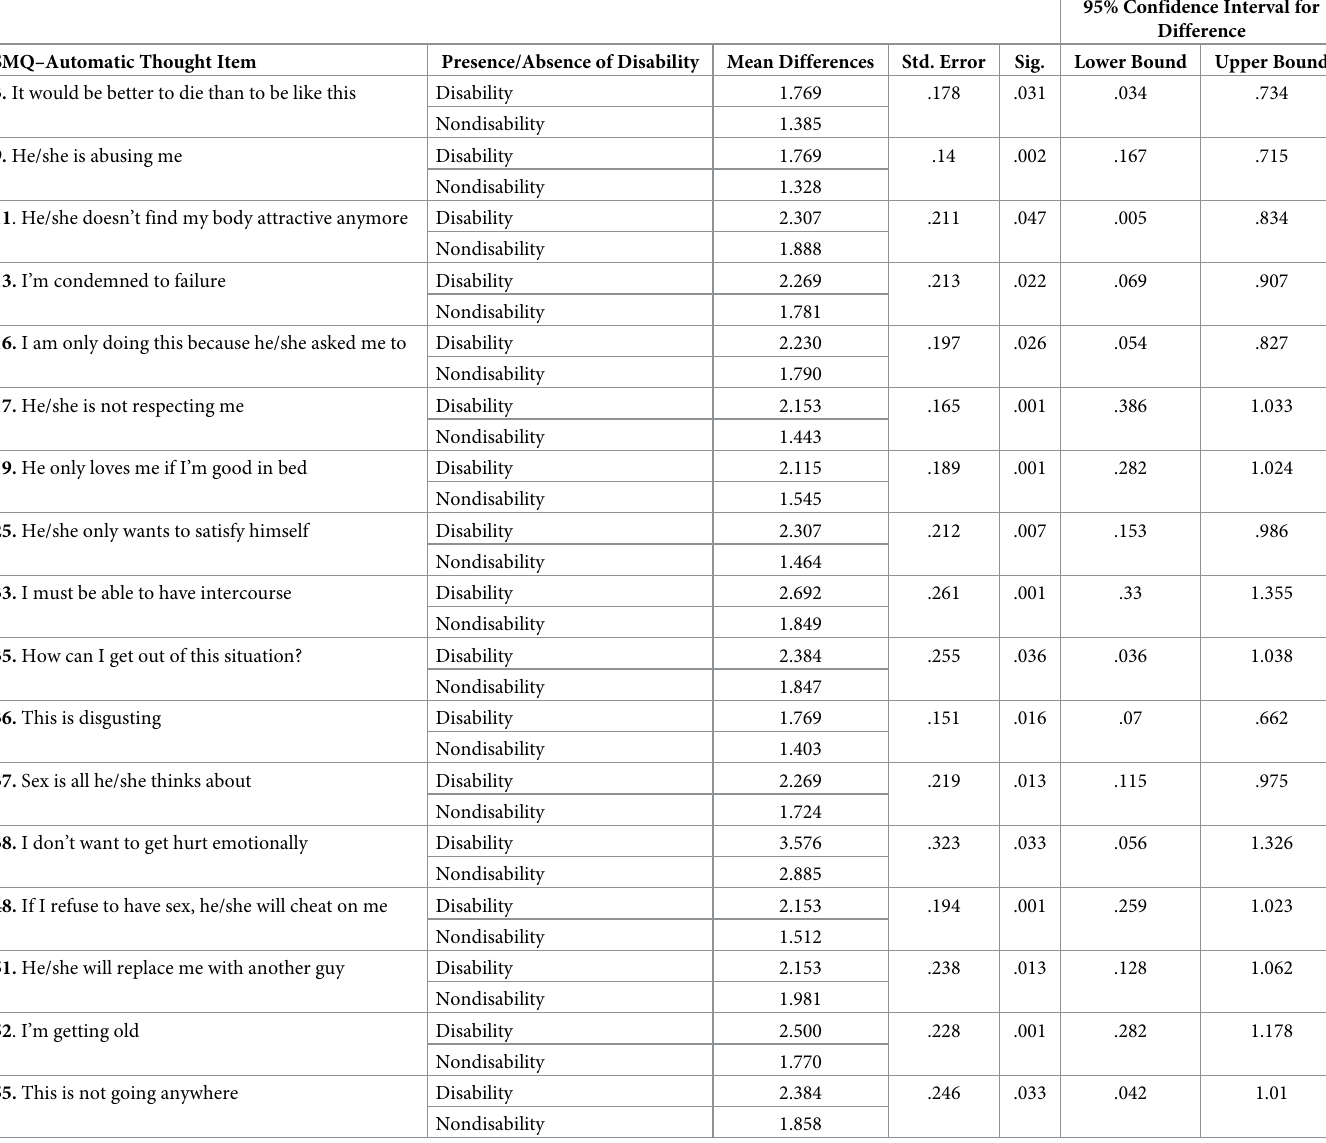
95% Confidence Interval for Difference